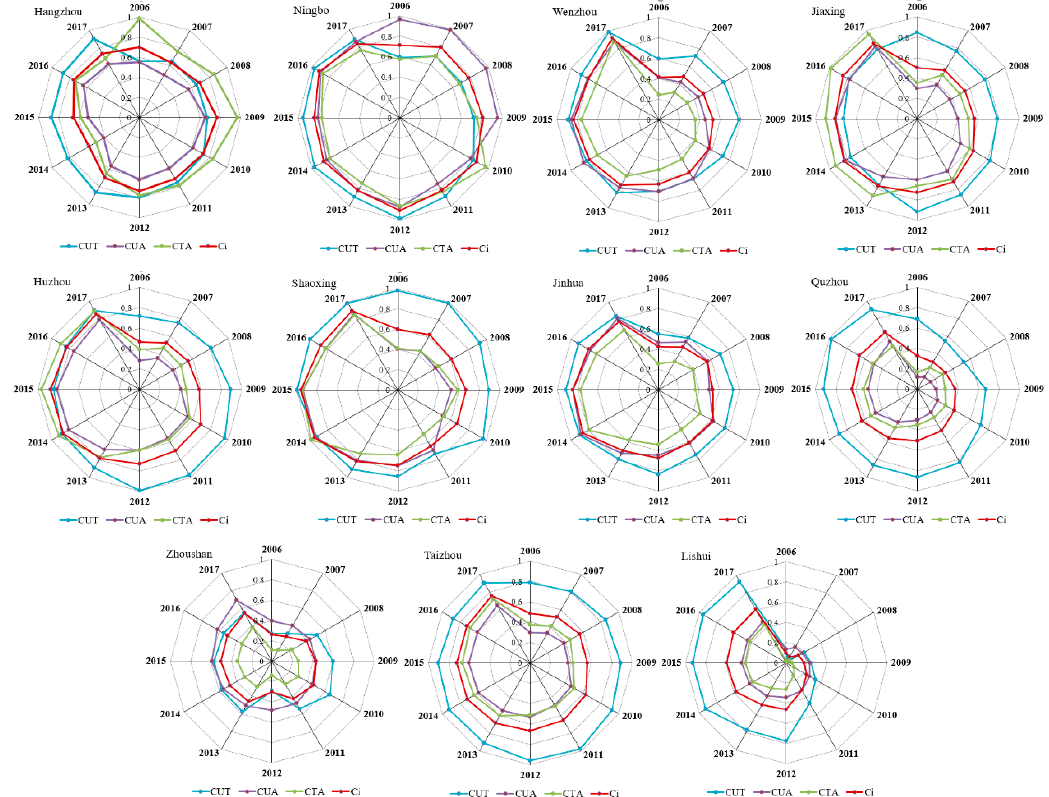
Figure 6. Radar map of the coordination degree of 11cities in Zhejiang in 2006–2017.